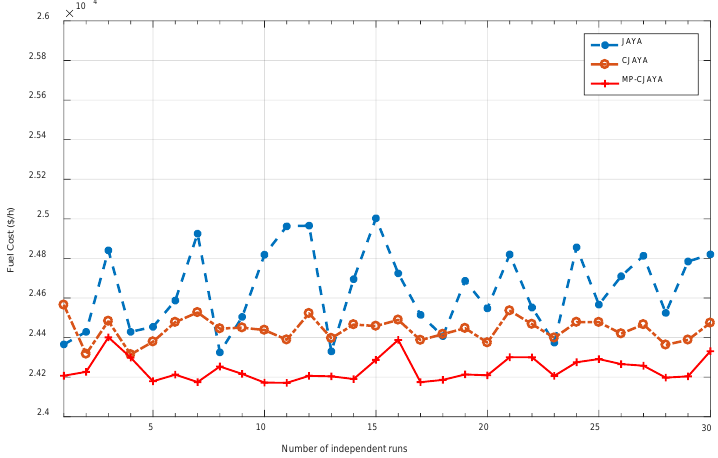
P = 2520 MW). Figure 5. Fuel cost for 30 independent runs of 13-units system ( P D = 2520 P = 2520 MW). D D